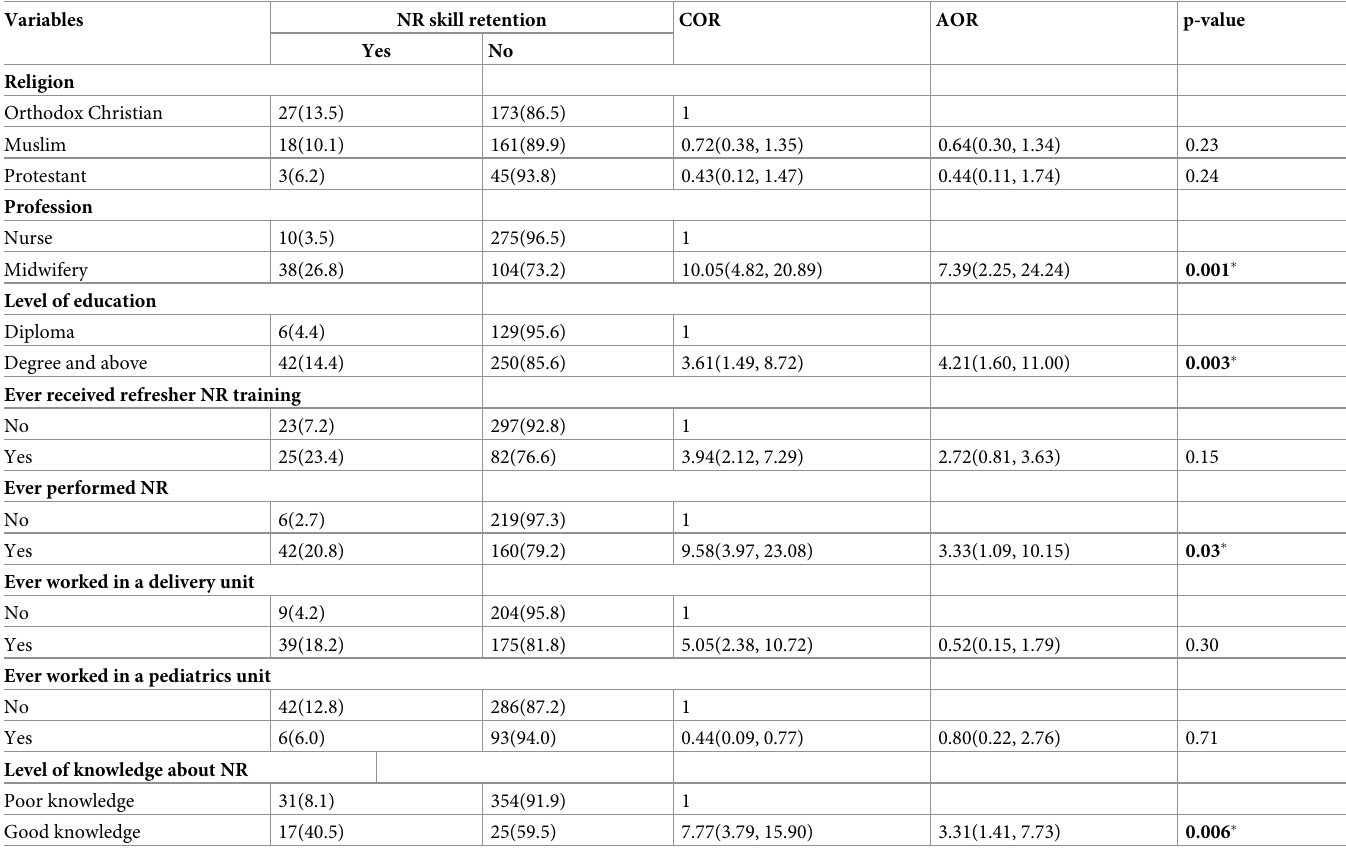
Table 2. Factors associated with neonatal resuscitation skill retention among midwives and nurses working in public health facilities in Eastern Ethiopia, November 2018 (n =